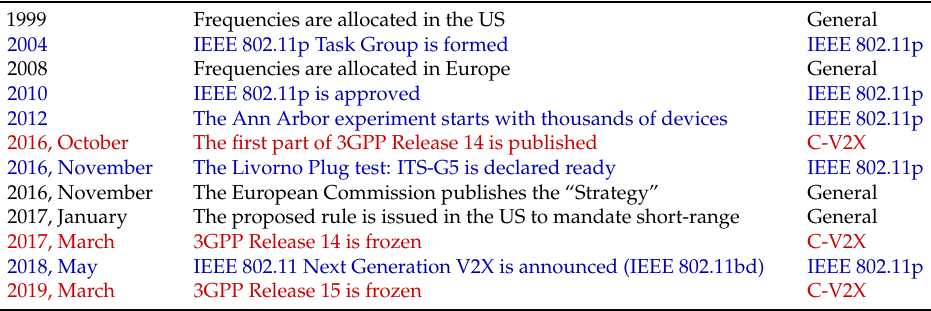
Table 1. Chronology of the main facts in the US and